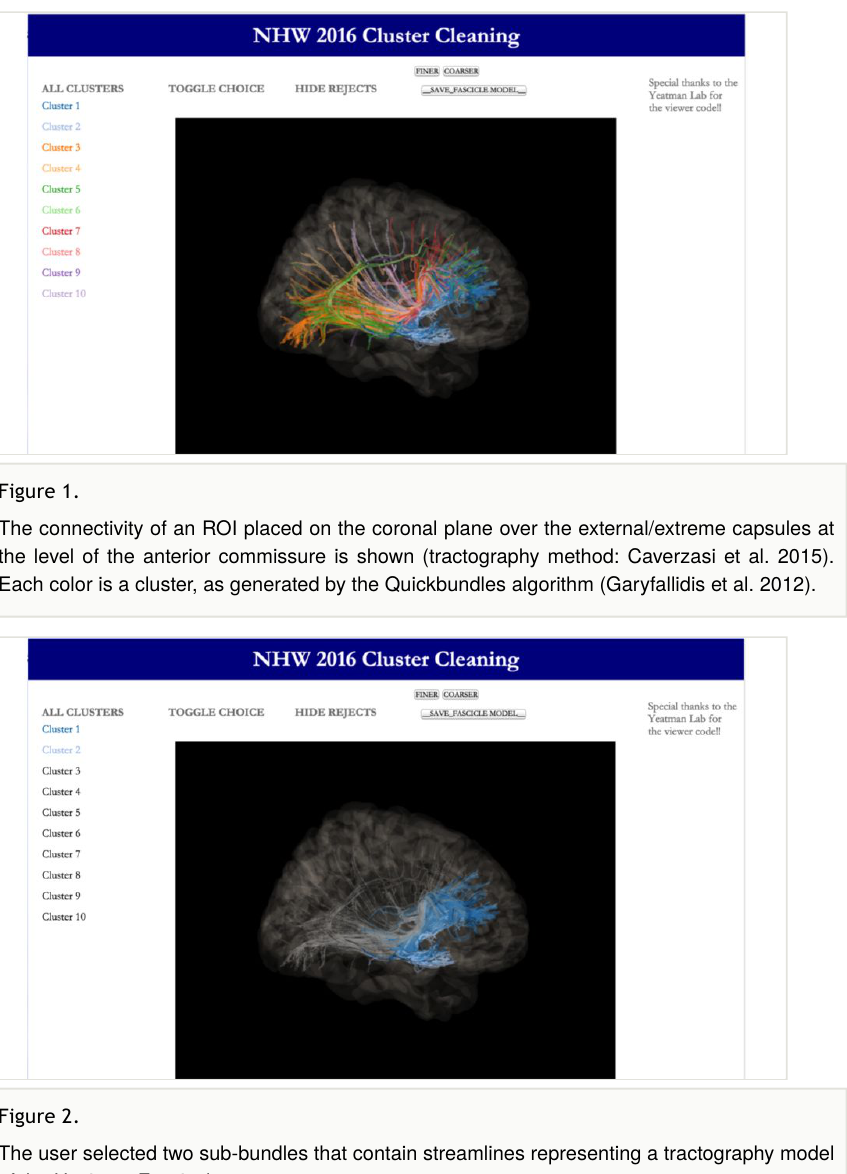
The user selected two sub-bundles that contain streamlines representing a tractography model of the Uncinate